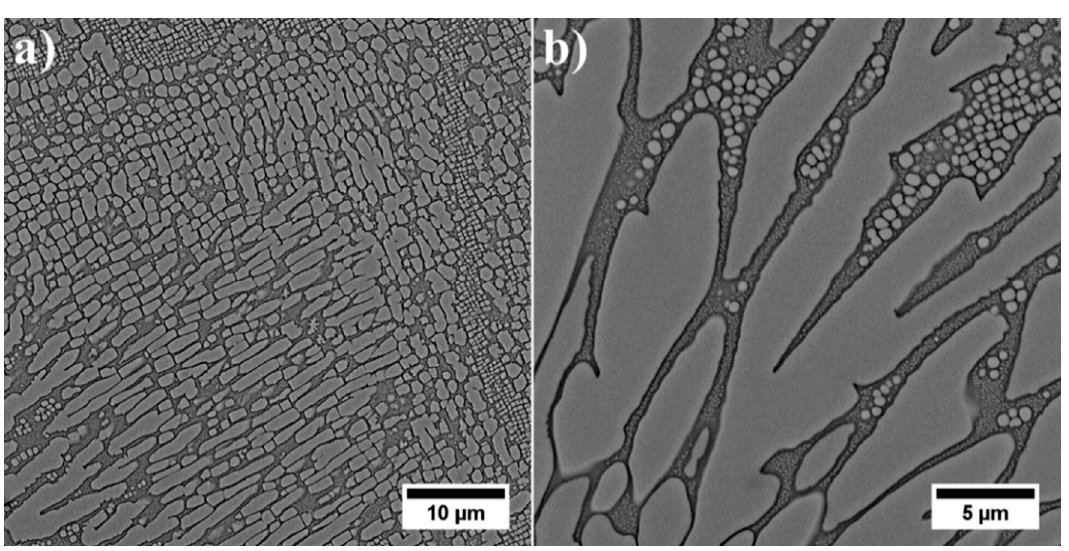
Figure 4. Morphology of γ ' precipitates: ( a ) interdendritic spaces; ( b ) detailed morphology of primary γ ' precipitates in interdendritic spaces.